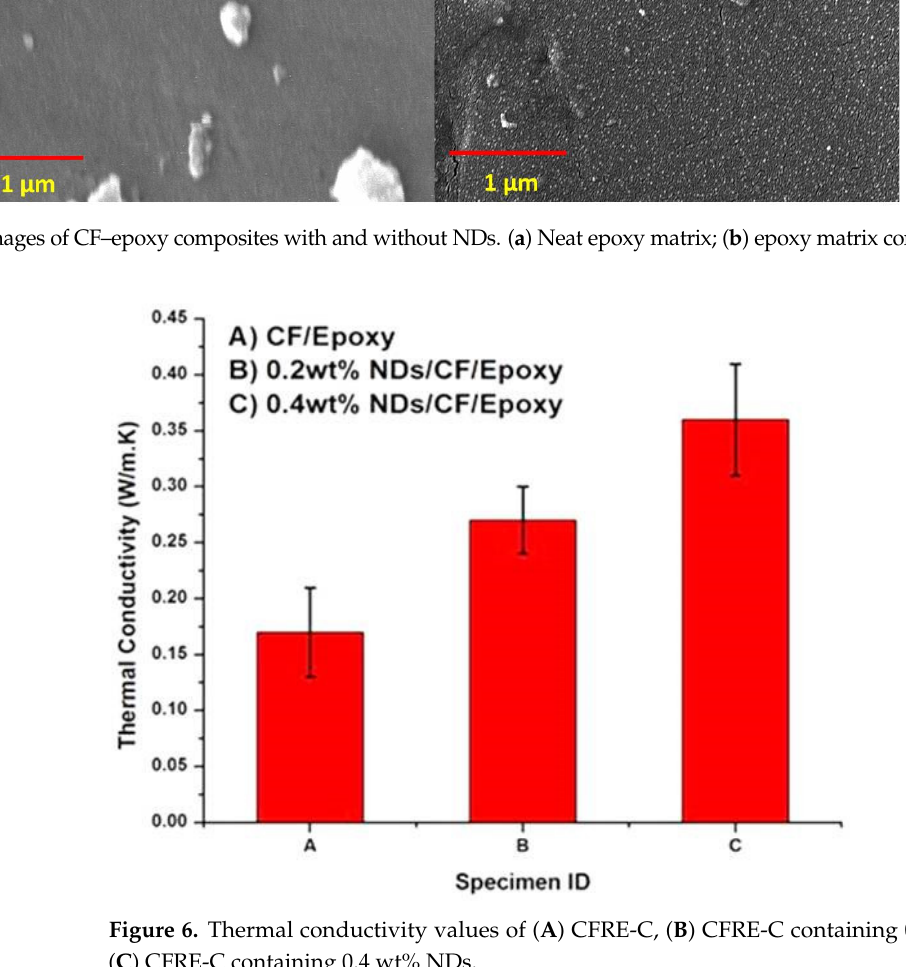
epoxy matrix containing NDs.